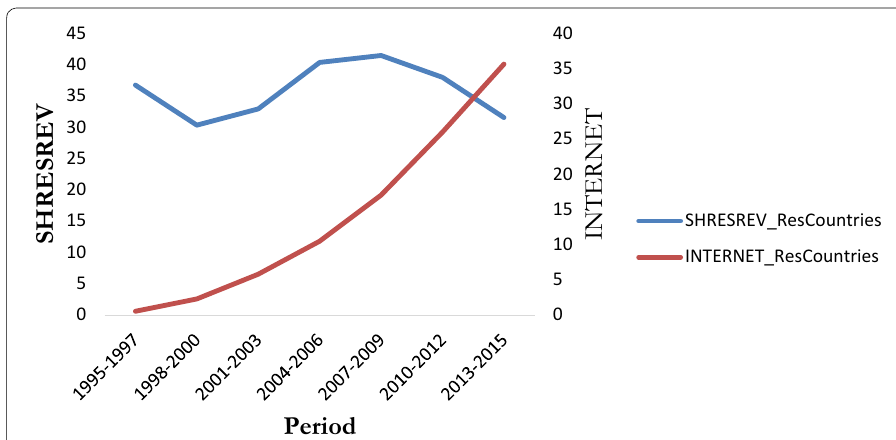
Fig. 2 Comparative evolution of “SHRESREV” and “INTERNET” over the sub‑sample of Resource Countries. Note : Non‑overlapping 3‑year average periods data have been used here. Source : Authors